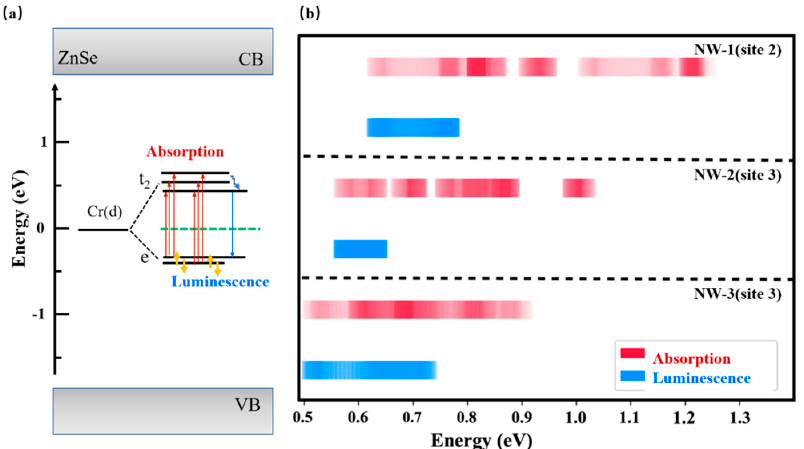
Figure 7. The absorption and luminescence calculation scheme ( a ) and numerical statistics of Cr(d) electrons transition energy density distribution of Cr 2+ :ZnSe NWs ( b ).